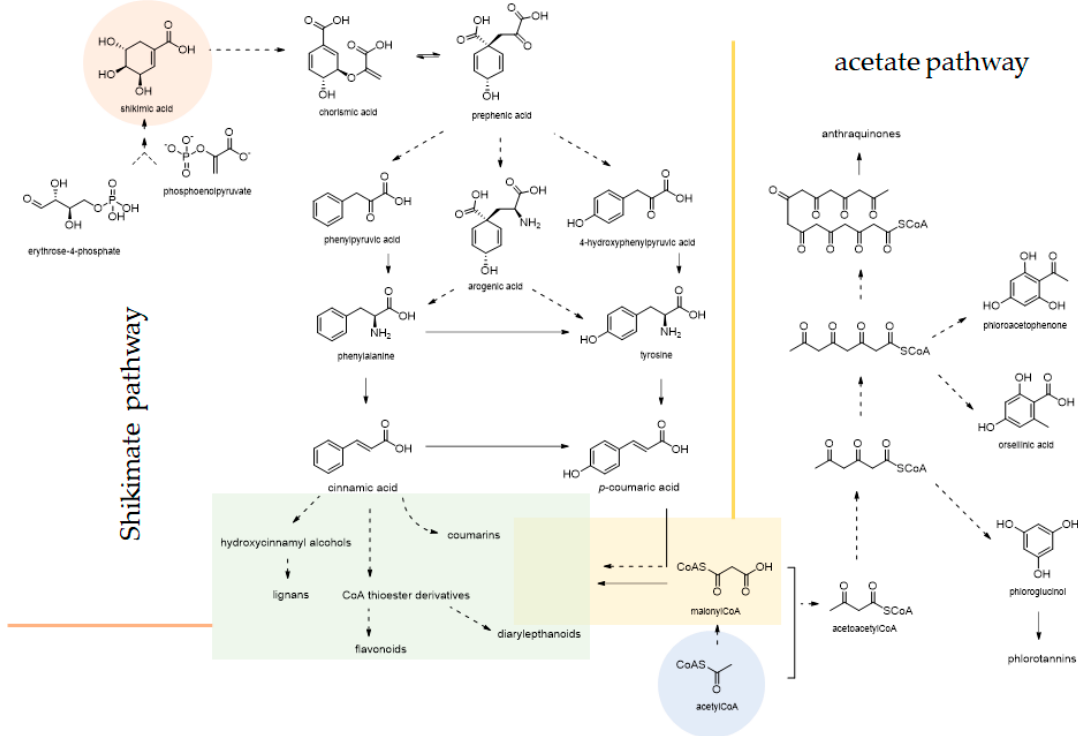
Figure 5. Phenols and polyphenols, which are shown to exert antiviral activity, originate from shikimate and acetate pathways. Most of them are the result of an intertwining of the two pathways. The shikimate pathway begins through the condensation of phosphoenolpiruvic acid (PEP) and erythrose-4-phosphate (E4P) by 3-deoxy-D-arabino-heptulosonate 7-phosphate synthase to produce 3-deoxy-D-arabino-heptulosonic 7-phosphate acid, which is promptly converted by the 3-dehydroquinate synthase in 3-dehydroquinic acid. This latter undergoes dehydration by the 3-dehydroquinate dehydratase to provide 3-dehydroshikimic acid, which is converted in shikimic acid through the action of shikimate dehydrogenase (SDH). Many intermediates of the shikimate pathway can be branch points leading to di ff erent C 6 C 0 , C 6 C 1 , C 6 C 2 and C 6 C 3 aromatic compounds, which can further act as precursors of more complex metabolites. This is the case of gallic acid, from which condensed and hydrolysable tannins are formed. The conversion of shikimic acid in chorismic acid by another PEP moiety condensation favored aromatic amino acids biosynthesis. Indeed, chorismic acid is converted by chorismite mutase via a pericyclic Claisen rearrangement, in prephenic acid, whose conversion to L-phenylalanine and L-tyrosine may occur via two alternative pathways. L-tryptophan is biosynthetized when chorismic acid is converted to anthranilic acid by anthranilate synthase. The nonoxidative deamination of L-phenylalanine by phenylalanine ammonia-lyase (PAL) forms trans -cinnamic acid, which is the parental compound for the biosynthesis of phenylpropanoids (e.g., hydroxycinnamic acids, lignans and coumarins), aromatic polyketide (e.g., diarylheptanoids, flavonoids, stilbenes, flavolignans and isoflavonoids) and terpenoid quinones. The acetate pathway could form fatty acids by fatty acid synthase (FAS) catalysis or polyketide systems by di ff erent polyketide synthases. Poly- β -keto chain is highly reactive and could undergo intramolecular aldol or Claisen reactions supplying. Phloroglucinol derives from a polyketomethylene chain formed by three malonyl-CoA units, whereas anthraquinones are from a 16-carbon poly- β -keto